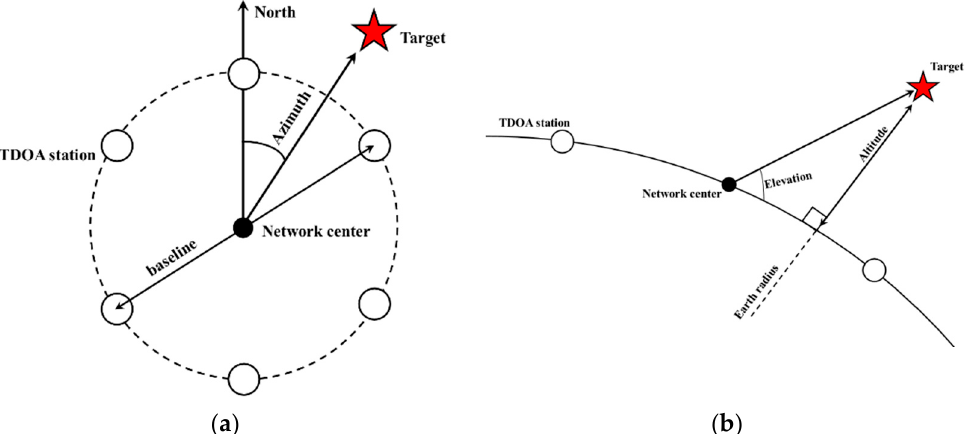
Figure 1. Graphical representation of the variables and factors that will be influencing the dilution of precision (DOP) and minimum dilution of precision (MDOP) values in the paper. Plot ( a ) shows the top view, plot ( b ) shows the side view.